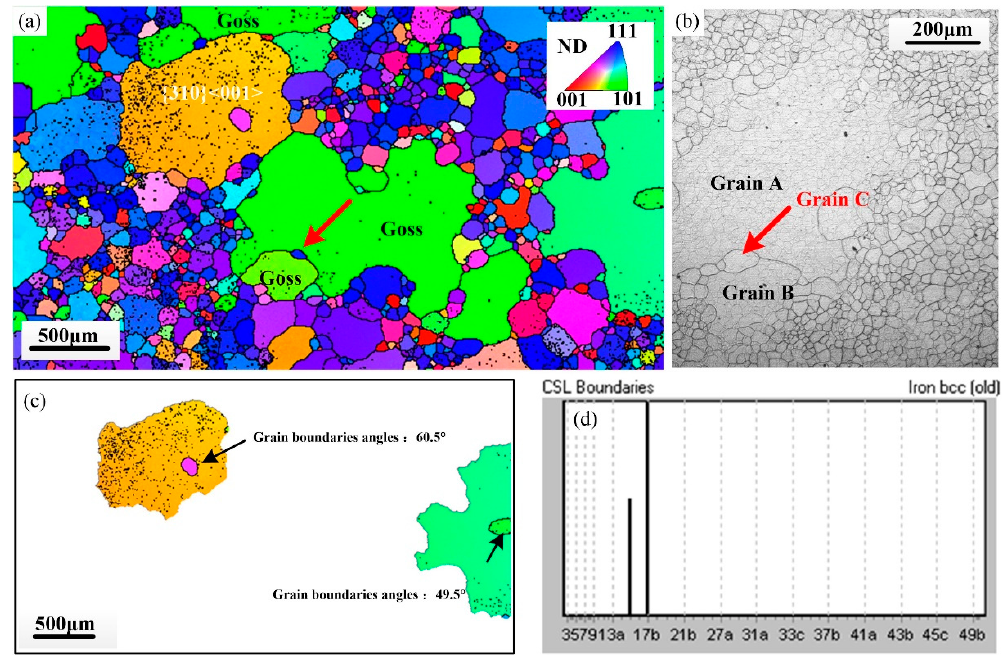
Figure 7. Orientation image map after secondary annealing in weak inhibition specimens ( a ), early stage of secondary annealing in the same position ( b ), orinetion image map of the island grains and abnormal grains ( c ), and the CSL boundaries distribution of island grains ( d ).